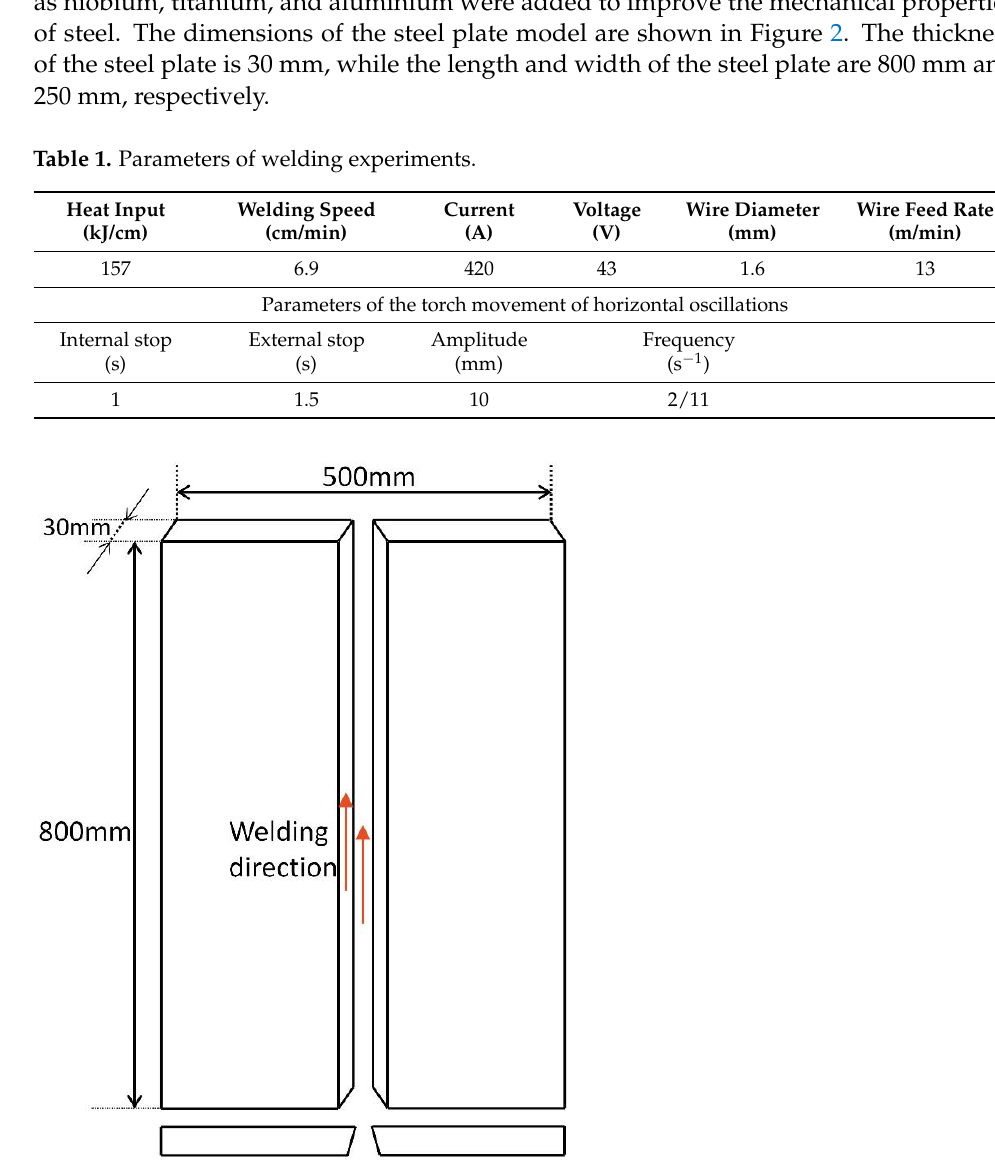
Figure 2. Geometry of welded steel plate.